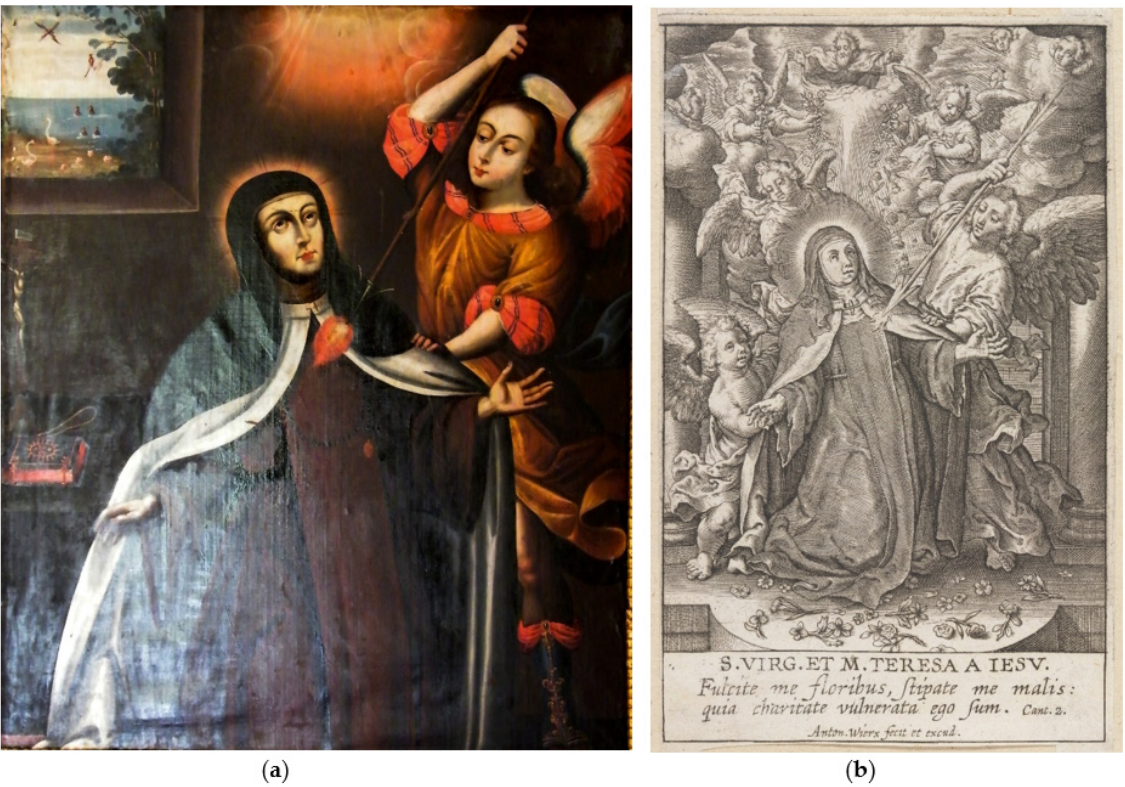
Figure 8. ( a ) Unidentified artist, Transverberation of Saint Teresa , 18th century, oil on canvas, Monasterio de Santa Teresa, Arequipa, Perú. Credit line: Sebastian Ferrero. ( b ) Anton Wierix, The Transverberation of St. Teresa , engraving. Credit line: The Metropolitan Museum, New York.